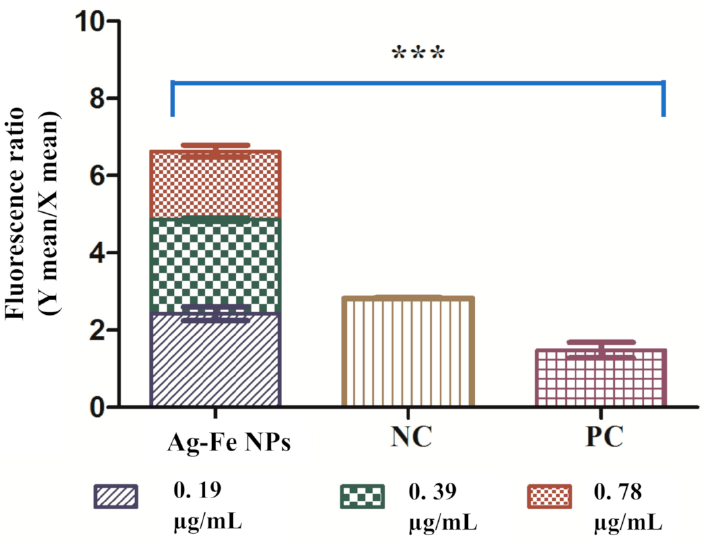
Figure 6. Decrease in mitochondrial membrane potential in C. auris cells exposed to different concen- trations of Ag–Fe NPs. Untreated cells represent the negative control (NC), and cells treated with 10 mM H 2 O 2 represent the positive control (PC). *** p ≤